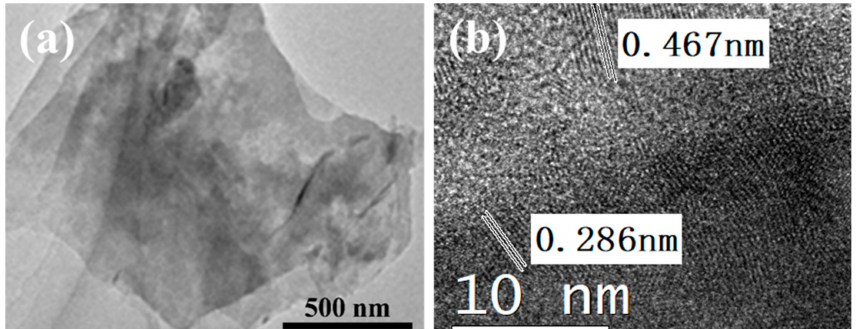
Figure 3. TEM ( a ) and HRTEM images ( b ) of the ZnCo 2 O 4